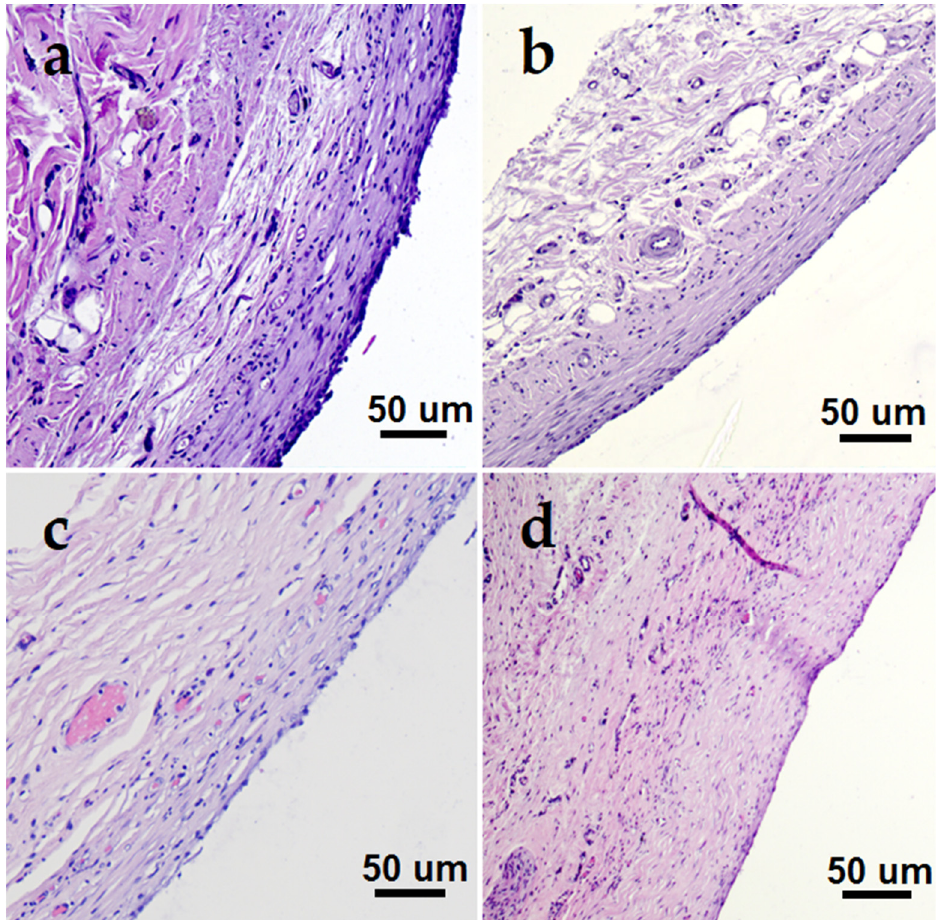
Figure 14. Fibrous capsule micrographs demonstrating different morphology structures (( a )—dense capsule around CFR-PEEK, ( b )—two-layered capsule around Ag/PtIr/CFR-PEEK, ( c )—microvessel- enriched capsule around Au/CFR-PEEK, ( d )—capsule of maximum thickness within a studied series around Au/Pt/CFR-PEEK).